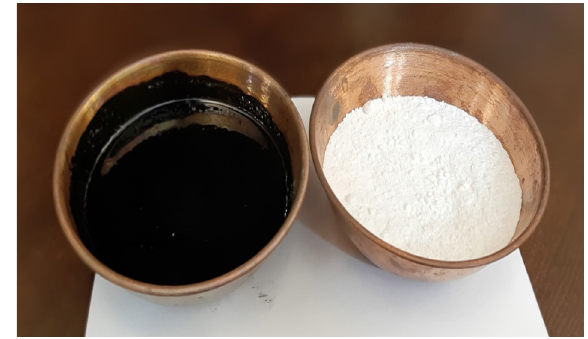
Figure 1. The neat bitumen and its modifier (LUS-1)